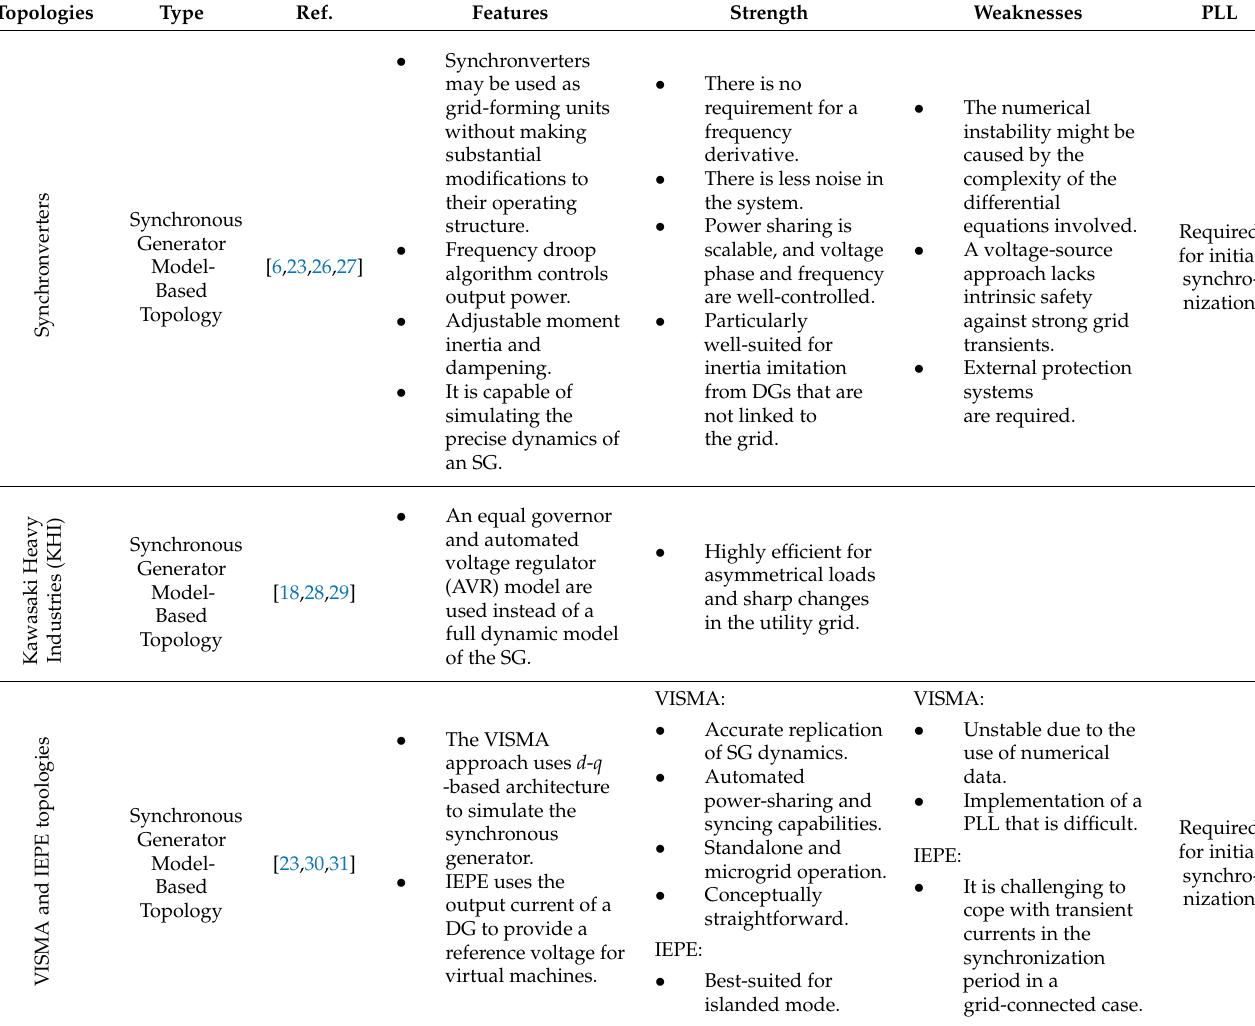
Table 1. Key features of VSM topologies.